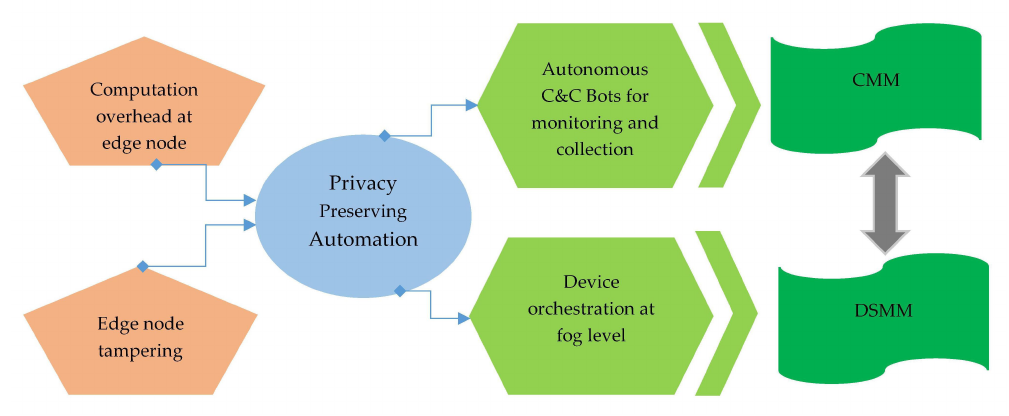
Figure 6. Privacy preserving automation